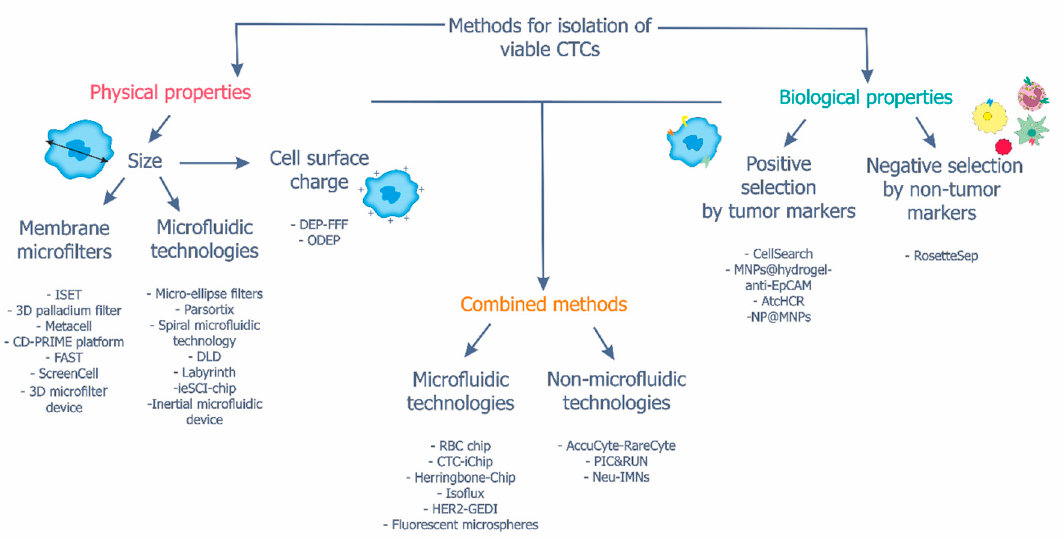
Figure 2. Methods for isolating viable CTCs. Viable CTCs can be isolated by methods based on physical (cell size and surface charge) and biological (specific markers) cell properties and combined methods that simultaneously consider the physical and biological features. The names of specific methods are provided.